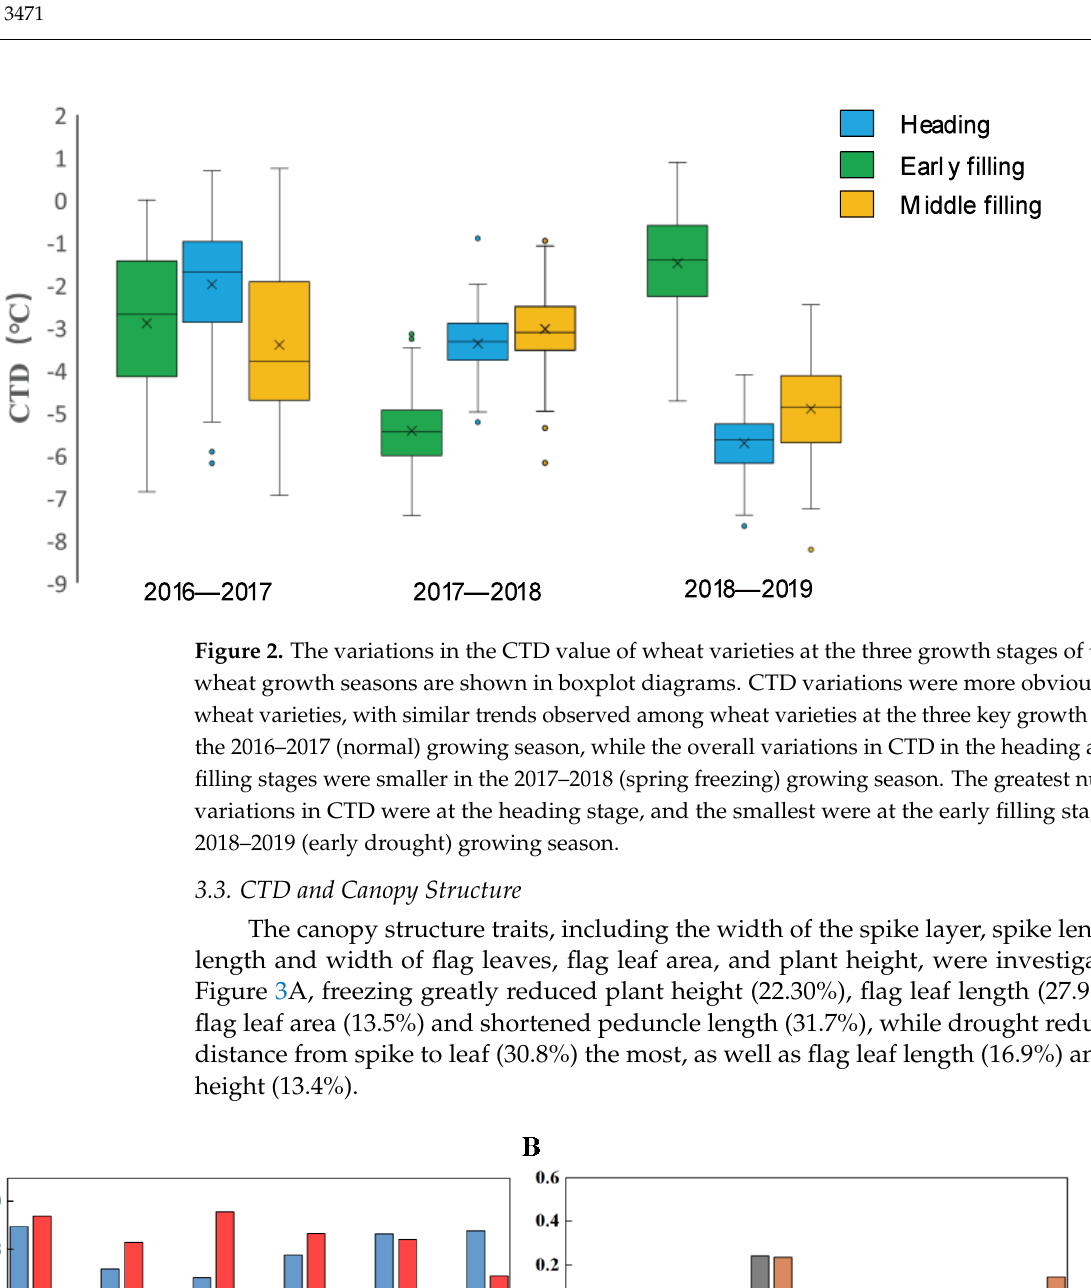
Table 1. Correlation coefficients of CTDs between the three growth stages of the three growing sea- sons.